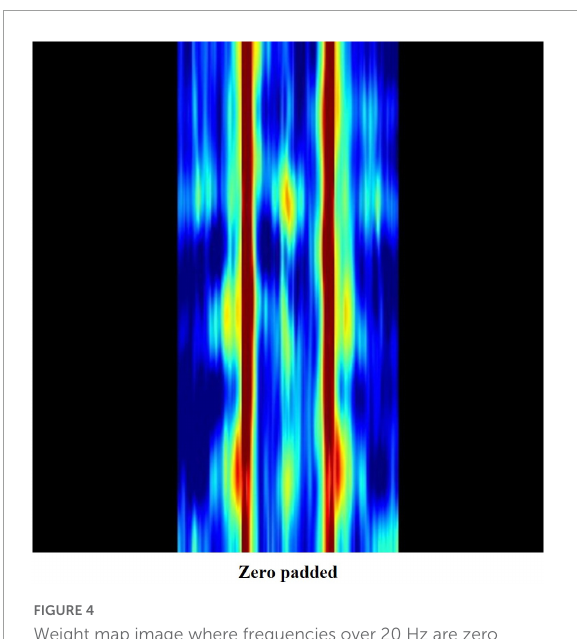
are easily contaminated by electromyography or external noise.